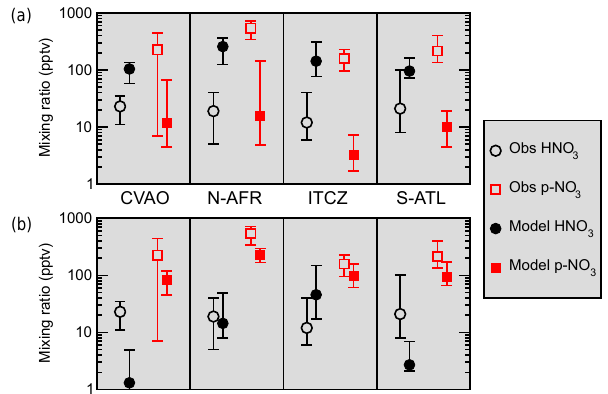
Figure 1. Comparison of modeled gas-phase HNO 3 and accumulation- plus coarse-mode particulate nitrate (p-NO 3 ) from the standard (a) and updated (b) models with measurements. CVAO HNO 3 measurements are for open ocean air masses from the spring 2007 RHaMBLe campaign (Lawler et al., 2009), while p-NO 3 mea- surements are from the summer marine aerosol subset of samples from 2007 to 2011 (Fomba et al., 2014). N-AFR, ITCZ, and S- ATL HNO 3 and p-NO 3 shipboard measurements are for the North Africa, ITCZ, and South Atlantic transport regimes in the eastern Atlantic during November 2003 (Keene et al., 2009). Model results are for May (CVAO HNO 3 ), June–August (CVAO p-NO 3 ), and November (N-AFR, ITCZ, and S-ATL HNO 3 and p-NO 3 ) from the 2014–2015 simulations. Symbols and lines indicate (i) means and ranges and/or 2 standard deviations for measurements and (ii) me- dians and 5th and 95th percentiles of daily means for